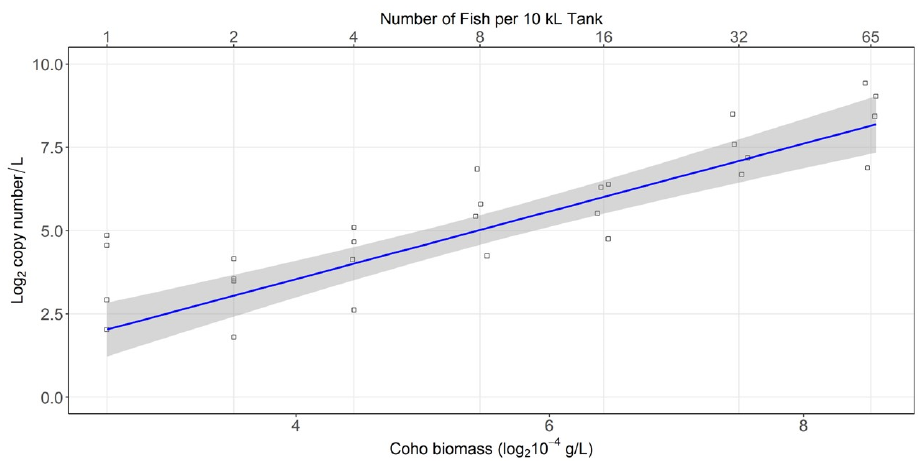
Figure 3. Density experiment results from 10 kL tanks at the Goldstream hatchery showing observed and predicted copy number (log 2 copy number/L) for the coho salmon assay eONKI4 versus juvenile coho salmon biomass (log 2 10 − 4